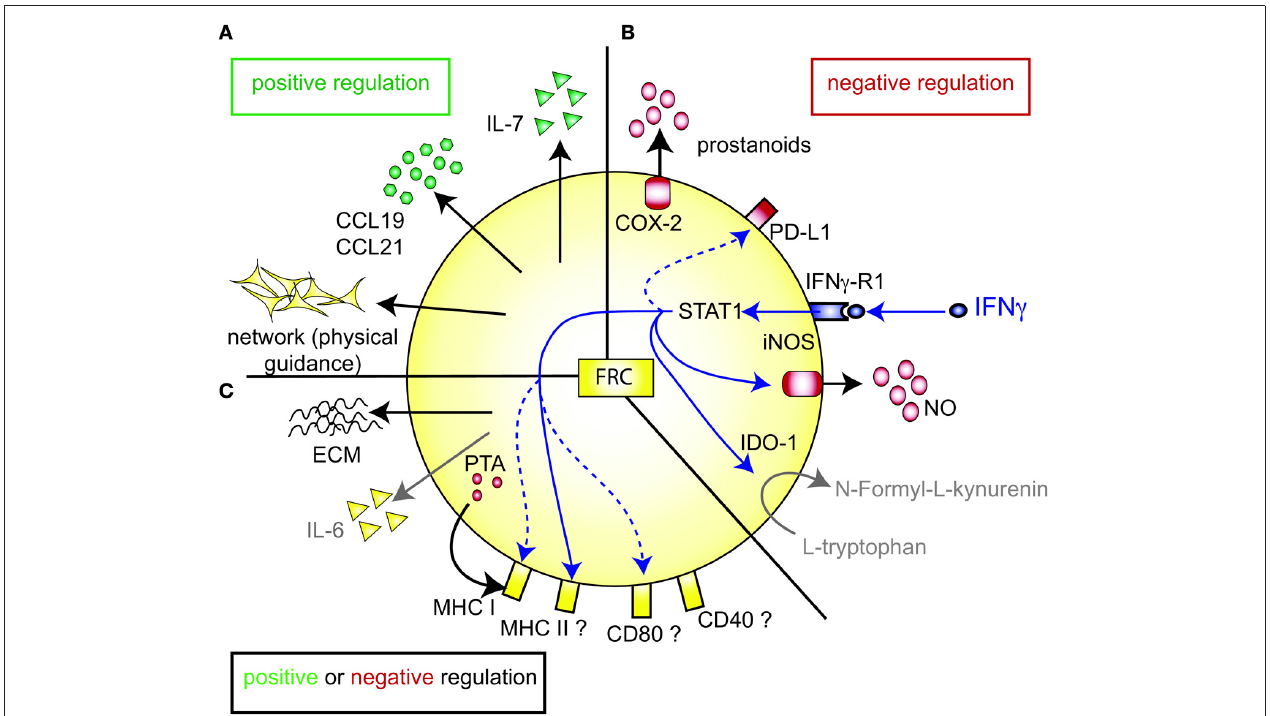
FIGURE 1 | FRC-expressed molecules that positively or negatively regulate the T cell response. (A) FRC are thought to positively regulate T cell immunity in several ways. Throughout the T zone of SLO FRC form a three-dimensionalnetworkthat serves as a scaffold for DC adhesionand T cell migration, thereby increasing DC-T interaction. In addition, FRC constitutively produce CCL19 and CCL21 that retain T cells in the T zone while increasing their motility. FRC also constitutively produceIL-7that promotesT cell survival. CCL19, CCL21, and IL-7 may all serve as co-stimulatory signals in case of weak T cell receptor triggering. (B) FRC express several molecules that may negatively regulate the immune response: COX-2 and PD-L1 are constitutively expressed, while iNOS and IDO-1 are only expressed after induction by IFN γ . iNOS expression in FRC is also induced by other pro-inflammatory cytokines, such as TNF α , IL-1 β and IFN α (not shown). PD-L1 expression on FRC is increased by LCMV infection, IFN γ or TLR3 stimulation (Mueller et al.,